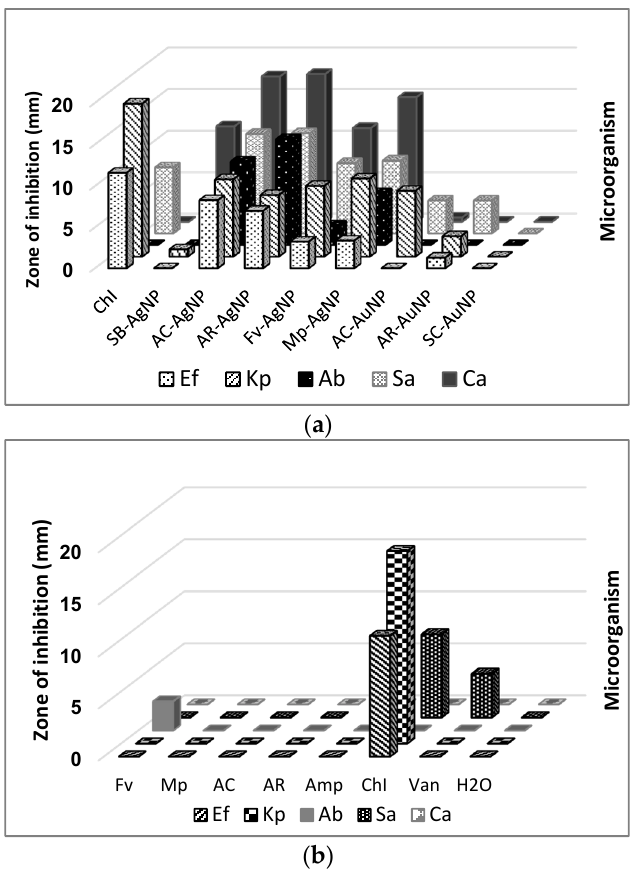
Figure 10. Antimicrobial activity (well-diffusion assay) against a panel of microorganisms (Ab = A. baumannii , Kp = K. pneumoniae , Ef = E. faicalis , Sa = S. aureus , Ca = C. albicans ) for ( a ) the synthesised nanoparticles and ( b ) the aqueous extracts (AC and AR), fucoidans (Fv and Mp), and controls: Vancomycin (Van), Ampicillin (Amp), Chloramphenicol (ChI) and water (H 2 O). NP concentrations used: ~0.2 mM. [Van], [Amp] and [ChI]: 1 mg/mL. AC: Aqueous extract subjected to organic solvent partitioning. AR: simple aqueous extraction.